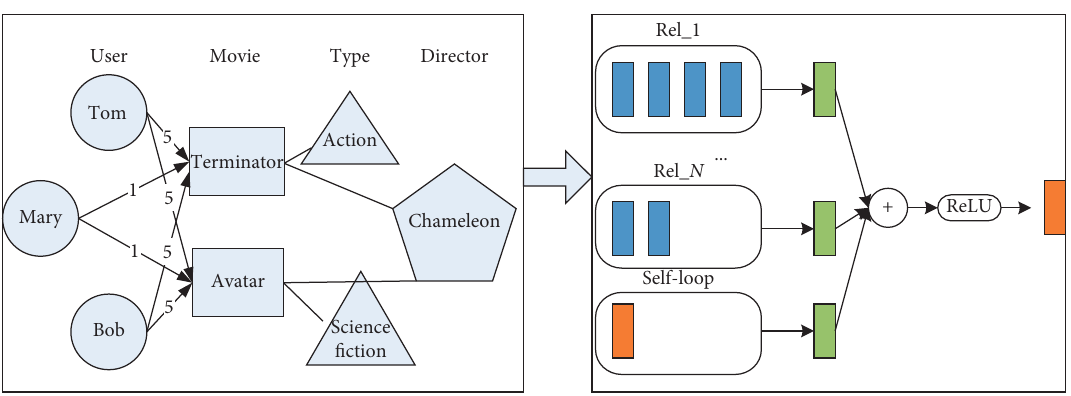
Figure 1: Example of the process of HGCR